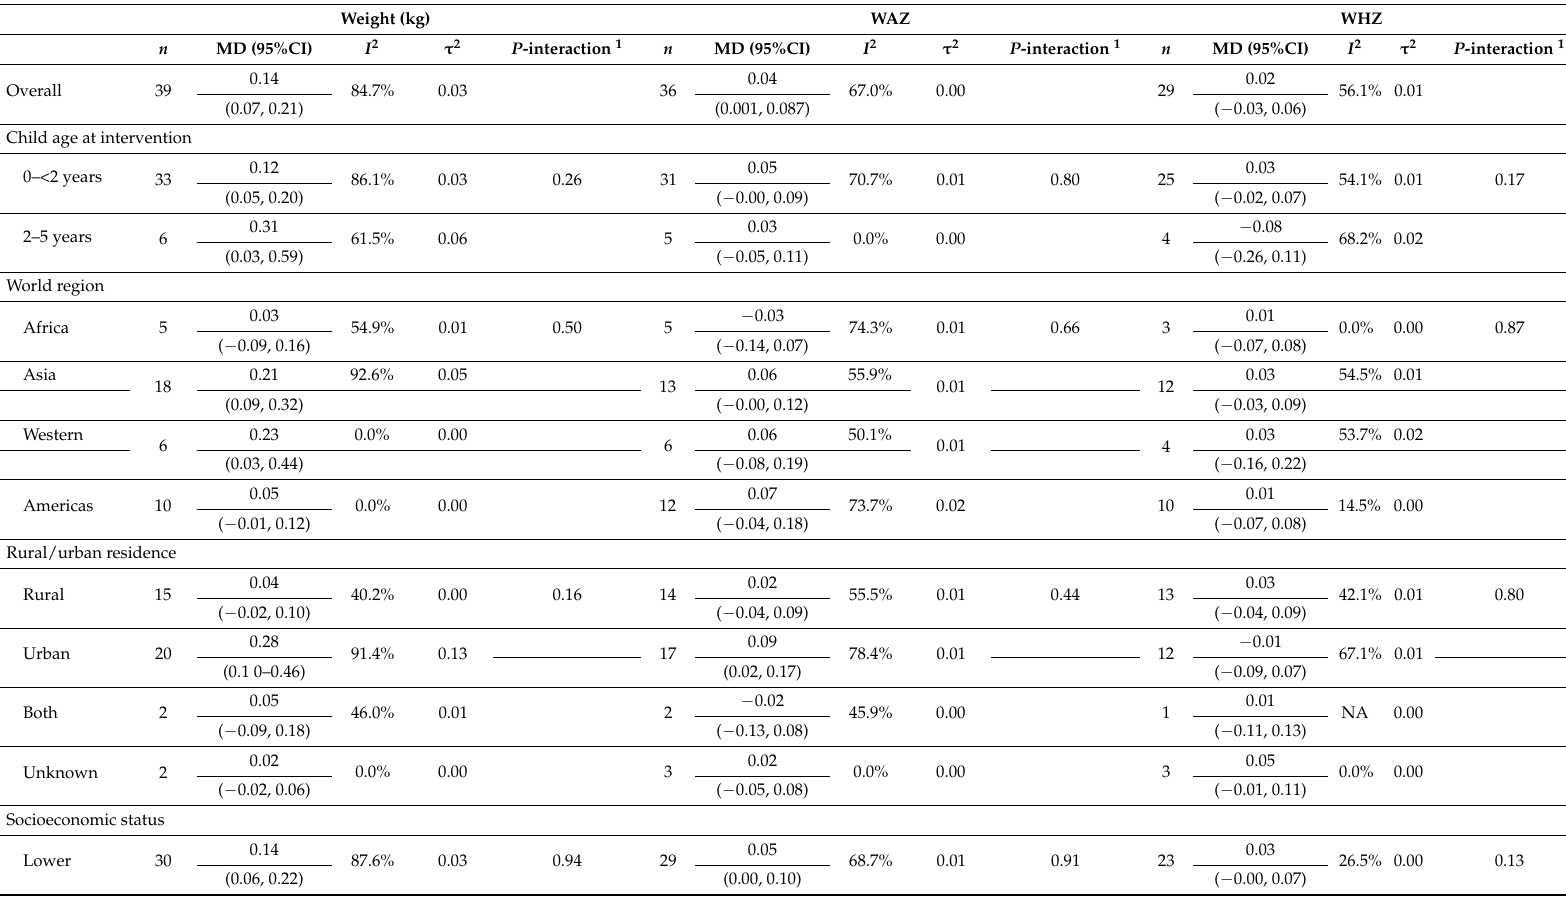
Table 4. Main and subgroup analyses of zinc supplementation during infancy/childhood on weight, weight-for-age and weight-for-height Z